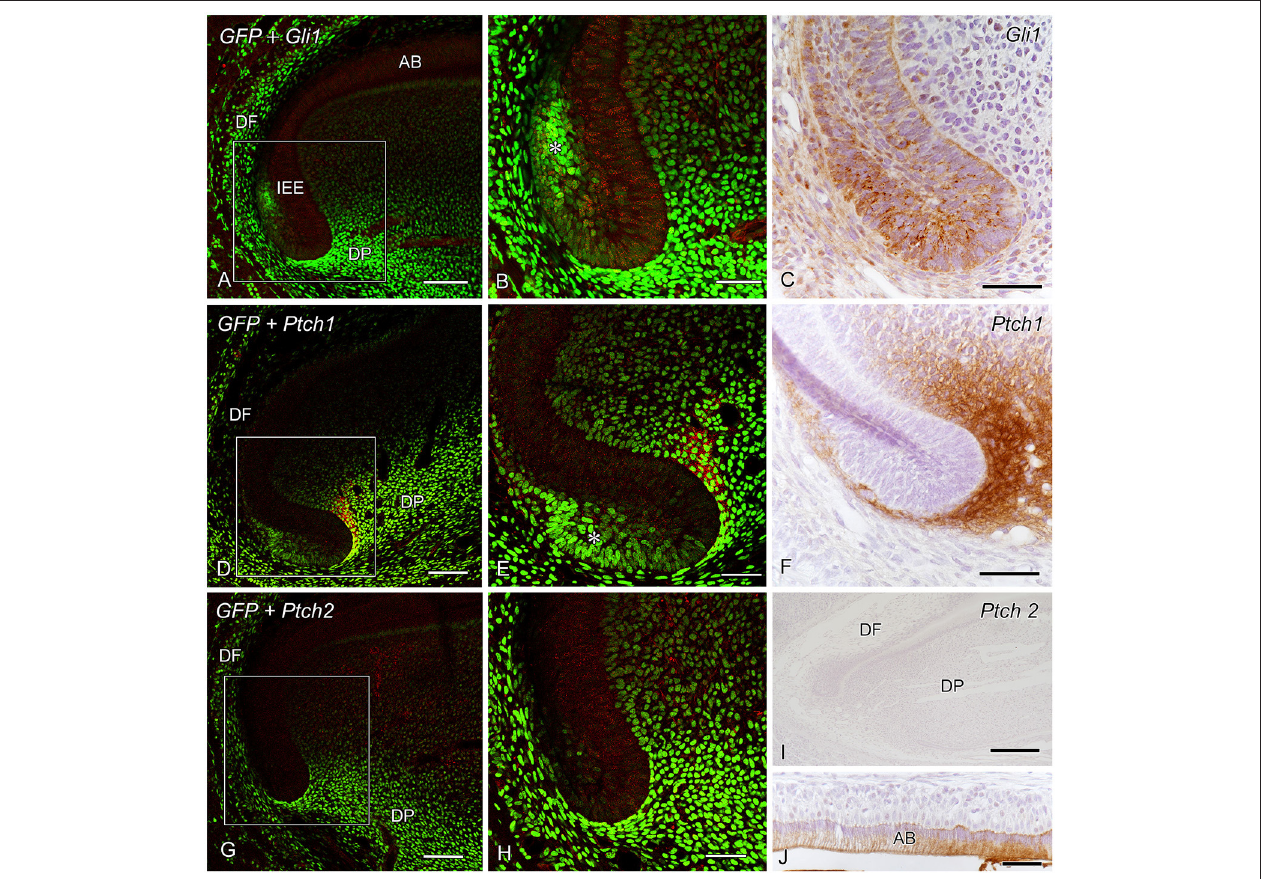
FIGURE 1 | Green fluorescent protein (GFP) expression and Gli1 immunoreactivity (IR) (A,B) , Gli1 IR (C) , GFP expression and Patched1 (Ptch1) IR (D,E) , Ptch1 IR (F) , GFP expression and Ptch2 IR (G,H) , and Ptch2 IR (I,J) in the apical end of incisors at postnatal week 3 (P3W) ( DF dental follicle, DP dental papilla). (A,B,D,E,G,H ) GFP + cells are observed throughout the dental follicle ( DF ) and the apical dental papilla ( DP ) in addition to the outer enamel epithelium of the apical bud (*). ( B,E,H ) Higher magnification of the boxed areas in (A,D,G) . (A–C) Gli1 + cells intensely localize in the inner enamel epithelium ( IEE ) and ameloblast layer ( AB ) in addition to the apical bud (*). (D–F) Ptch1 + cells are intensely localized in the apical dental papilla beneath the apical bud (*). (G–I) Intense Ptch2 expression is observed in the maturation ameloblasts (AB). Scale bars: 250 µ m (I) , 100 µ m (A,D,G) , and 50 µ m (B,C,E,F,H,J)